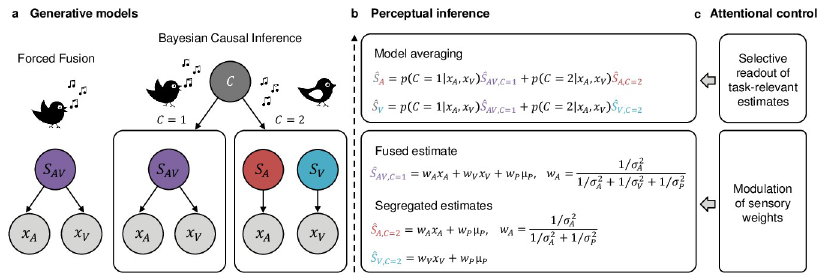
Fig 1. Bayesian Causal Inference and the possible roles of attentional control. (a) Generative models of Forced Fusion and Bayesian Causal Inference. For Forced Fusion, a single source generates auditory and visual signals. Bayesian Causal Inference explicitly models the two causal structures, i.e., whether auditory and visual signals come from one common cause ( C = 1) or from separate causes ( C = 2). (b) During perceptual inference, the observer is thought to invert the generative models; it infers the number of sources by combining prior knowledge and audiovisual evidence. A Forced Fusion estimate is computed by averaging auditory and visual estimates alone with prior spatial estimates weighted by their relative reliabilities (inverse sensory variance σ 2 ). The full segregation estimates, visual or auditory, are computed separately. To account for causal uncertainty, the final Bayesian Causal Inference estimate, auditory ( ^ S ) or visual ( ^ S ), is computed by combining the audiovisual Forced Fusion estimate A V ( ^ S ) with the task-relevant full segregation estimate, auditory ( ^ S ) or visual ( ^ S ), each weighted by the AV ; C ¼ 1 A ; C ¼ 2 V ; C ¼ 2 posterior probabilities of a common ( C = 1) or independent ( C = 2) causes. (c) Attentional control can mould multisensory perceptual inference via two distinct mechanisms and thereby induce differences in observers’ auditory and visual estimates. First, attending to a particular sensory modality may enhance the reliability of the signals in the attended sensory modality and thereby their weights during Forced Fusion. Second, modality-specific report (i.e., task relevance) determines the late readout consistent with the principles of Bayesian Causal Inference, i.e., whether the Forced Fusion estimate is combined with the auditory or visual full segregation